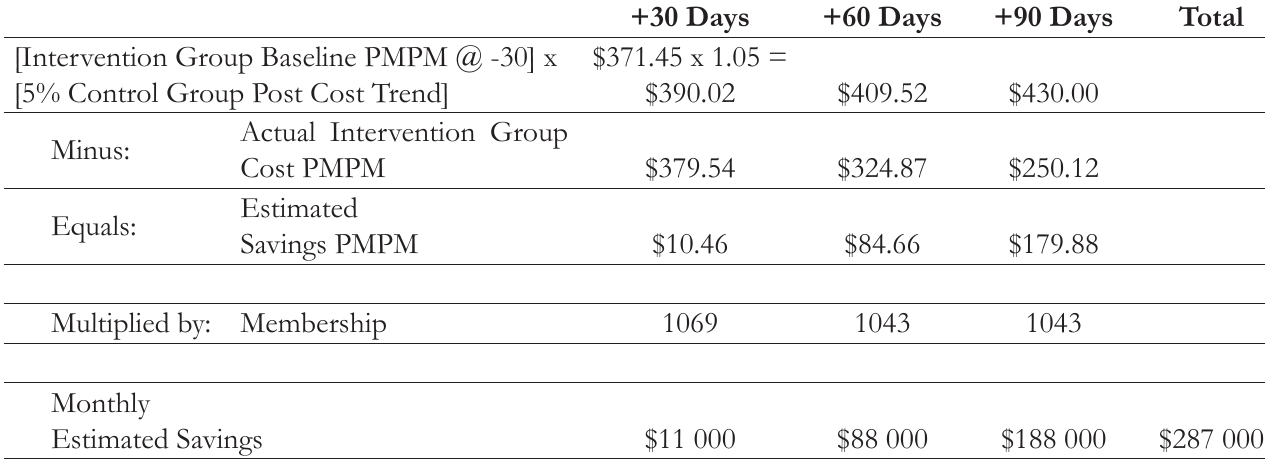
Table 3. Estimated Savings